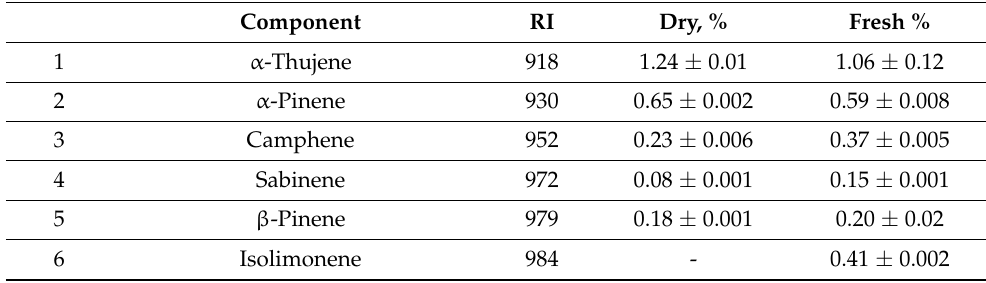
Table 1. Chemical constituents of the essential oils from fresh and dry Satureja nabateorum